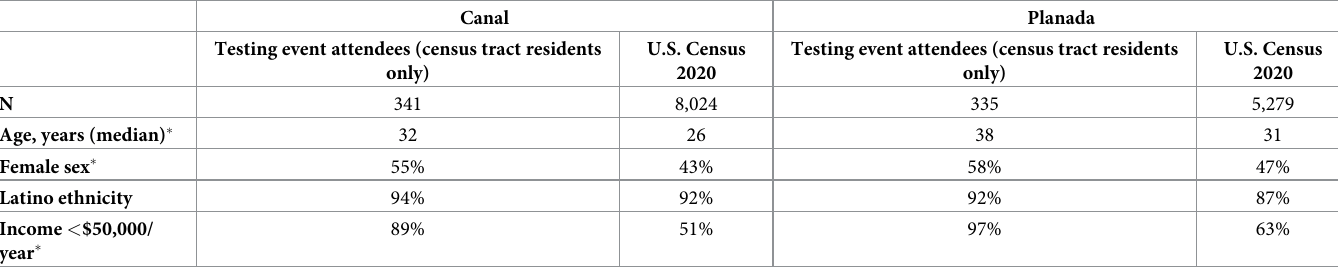
Table 2. A comparison of mass testing event attendee and U.S. Census tract demographic characteristics in the two study communities.